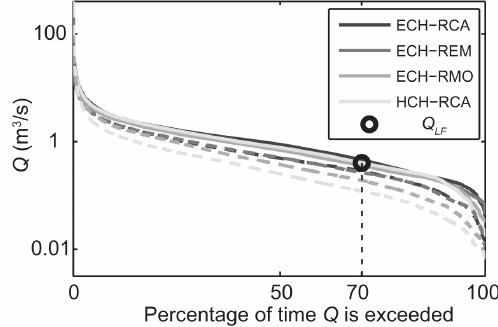
Figure 9. FDCs computed from the discharge at the RMB outlet. Continuous (dashed) lines are used for REF (FUT). Circle shows the threshold discharge, Q LF , used to identify low flow